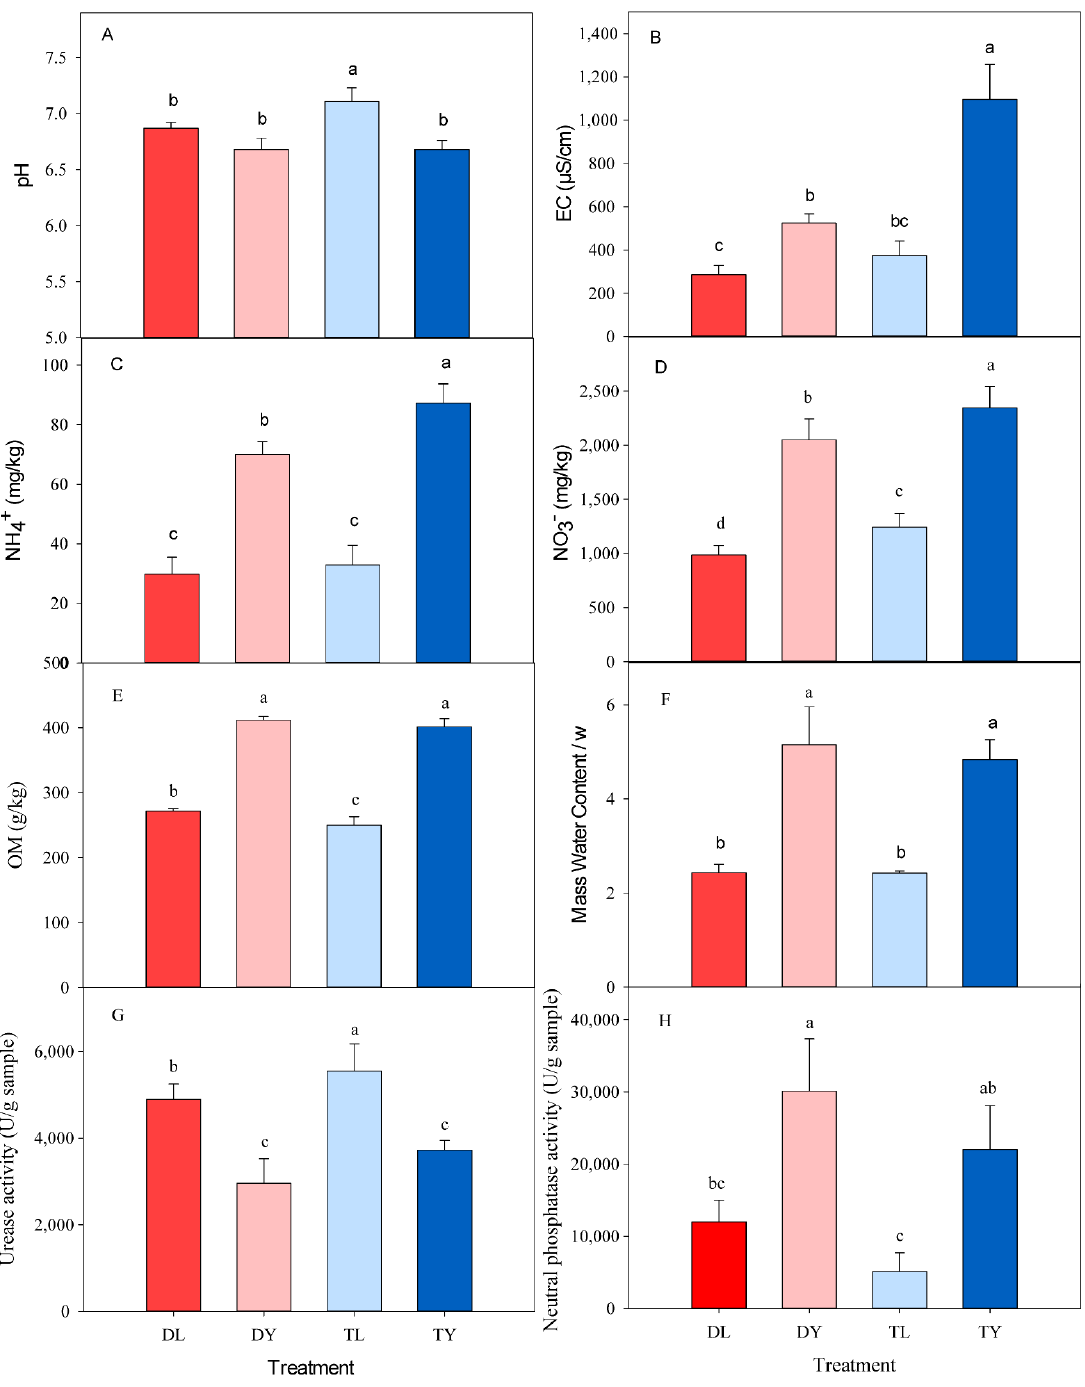
Figure 1. Characteristics parameters of different treatments. ( A ) pH; ( B ) EC; ( C ) NH 4+ content; ( D ) NO 3 − content; ( E ) OM content; ( F ) mass water content/ ω; ( G ) urease activity; ( H ) neutral phosphatase activity; DL, drip irrigation + peat-based substrate; DY, drip irrigation + coir substrate; TL, tidal irrigation + peat-based substrate; TY, tidal irrigation + coir substrate. The same below. Different lowercase letters indicate statistically significant differences at 5% level. Results are average values of the treatments ± SD (n =